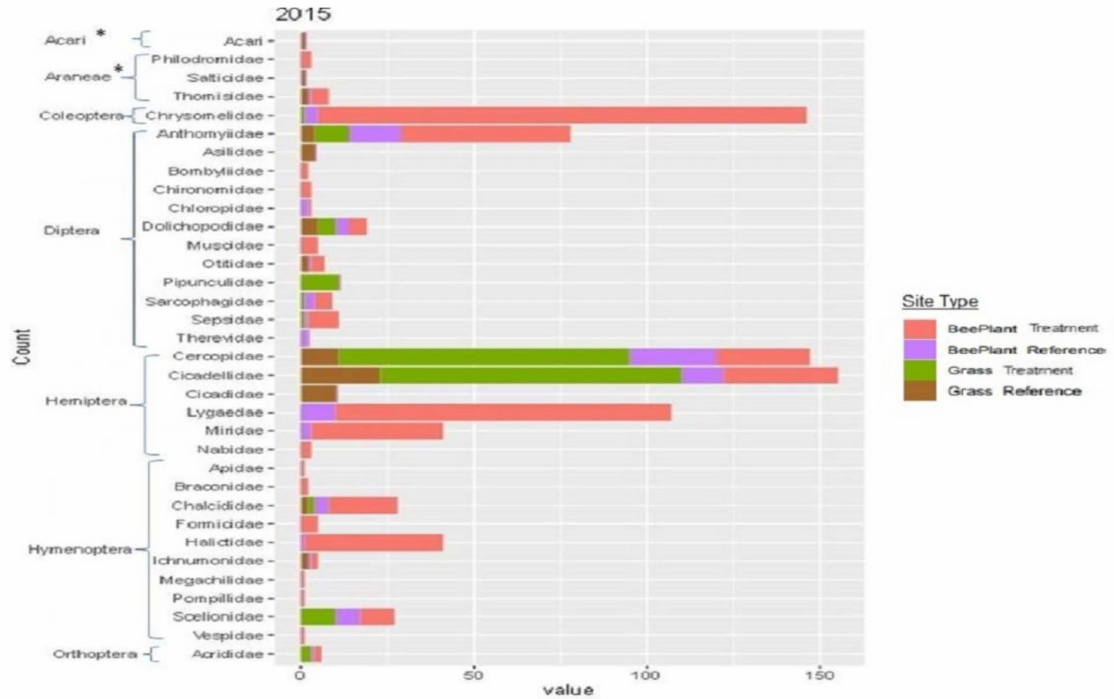
Figure 4. A stacked bar chart of insect abundance by family found on each site type in 2015. The * denotes arthropod orders and families within them which are not considered insects, but rather mite and